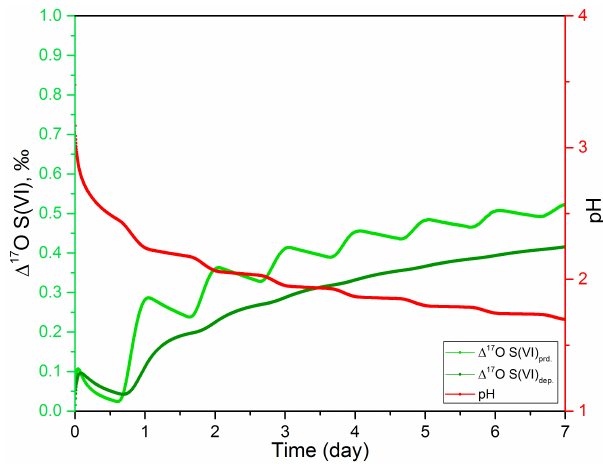
Figure 8. Time evolution of (cid:49) 17 O(S ( VI ) ) in produced and de- posited sulfates, and of pH of the liquid phases of volcanic plumes during simulation S3.